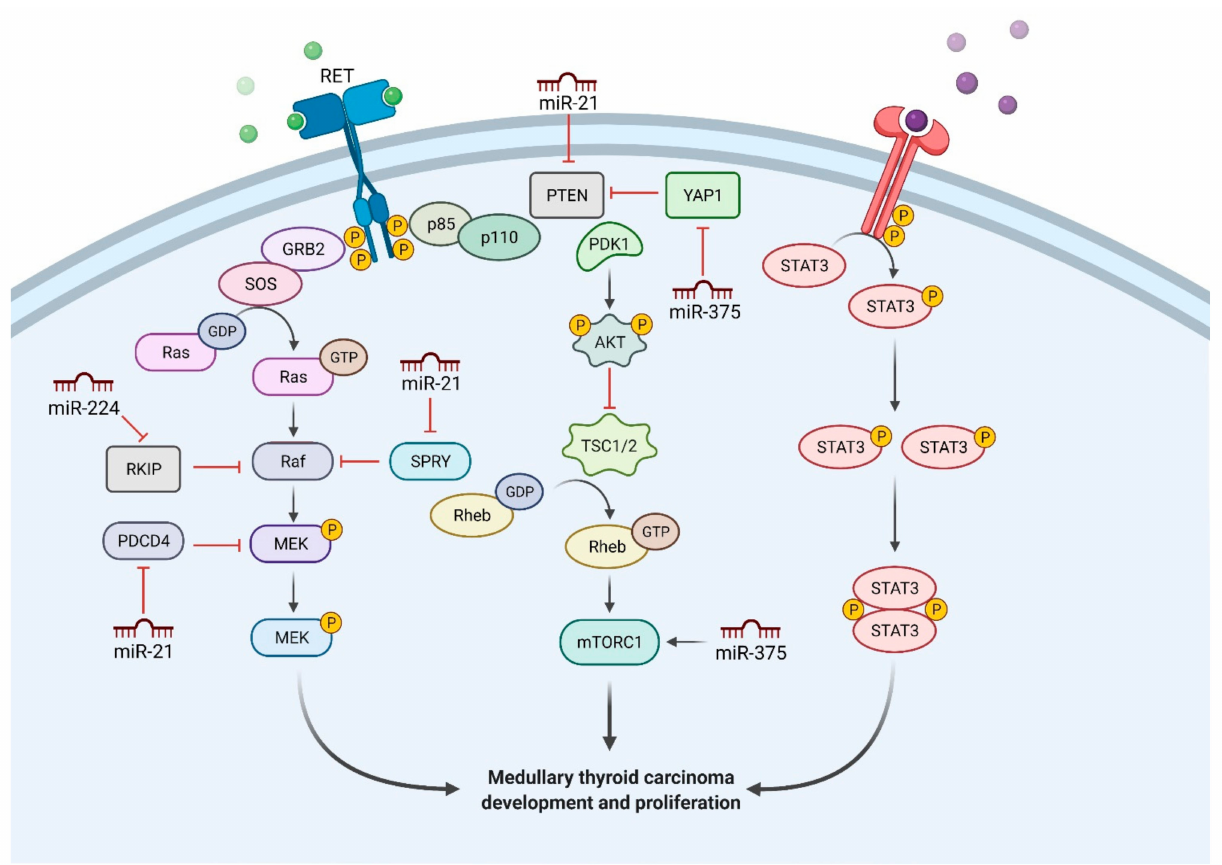
Figure 1. Molecular pathways involved in medullary thyroid carcinoma and development, showing regulatory functions of the most important miRNAs. Created using